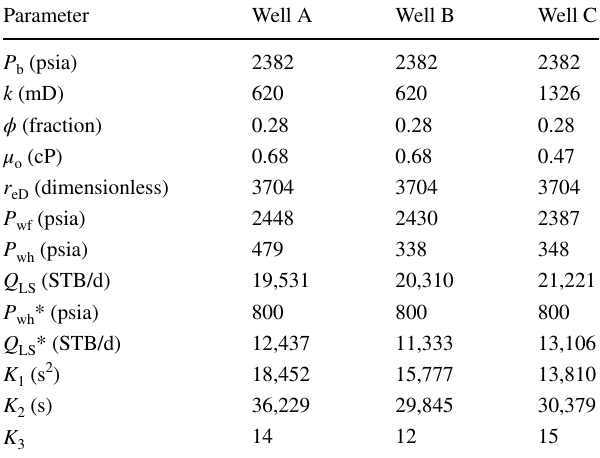
Table 3 Other input datasets required to evaluate the stability of wells A, B and C by the method of Blick et al.